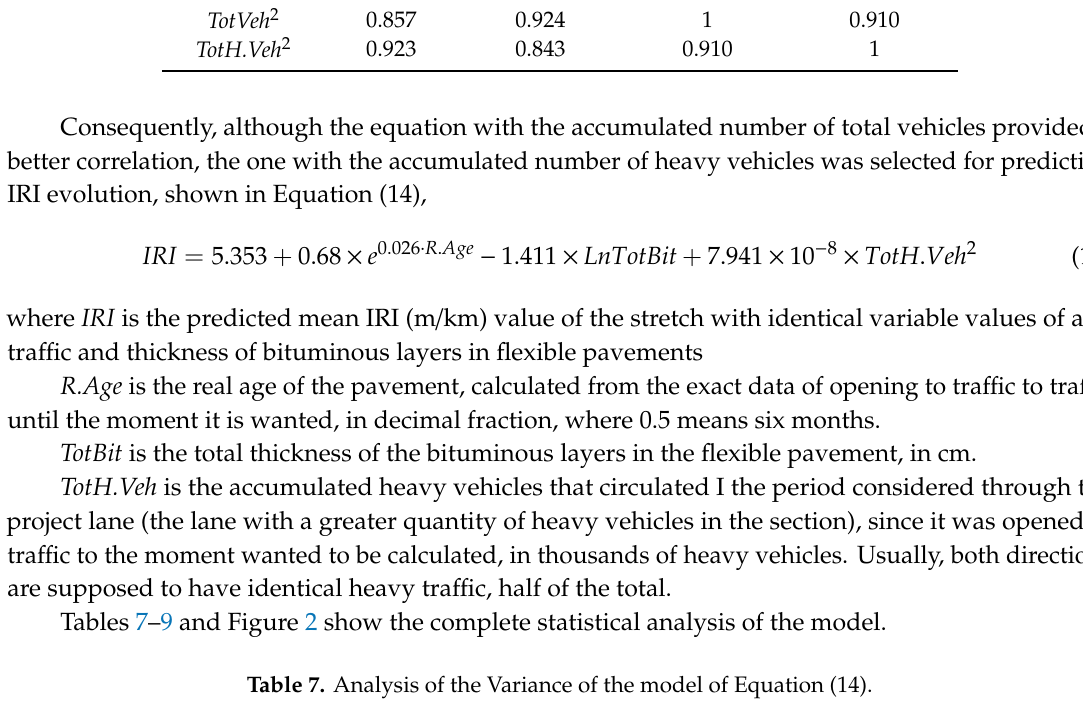
Table 6. Correlation between the variables related to accumulated tra ffi c (Pearson coe ffi cient, R ). TotVeh TotH.Veh TotVeh 2 TotVeh